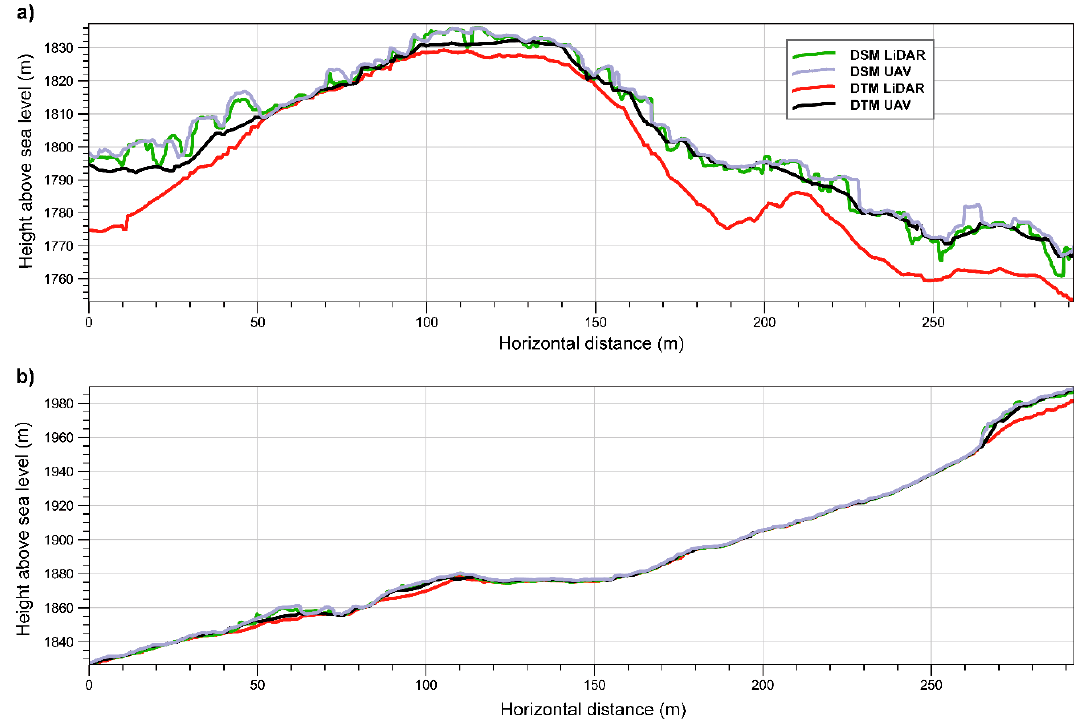
Figure 9. Transect profiles, comparing RGB and light detection and ranging (LiDAR) models: ( a ) Vegetated areas, ( b ) less vegetated areas.